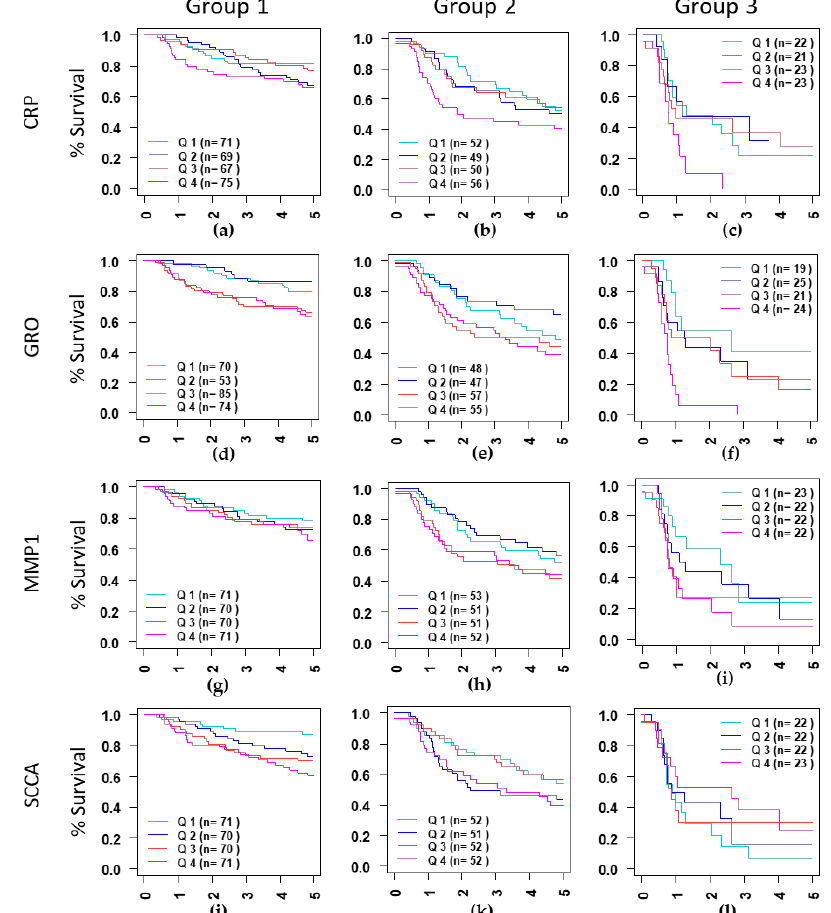
Figure 1. Kaplan-Meir curves curves for CPR ( a – c ), showing differences in survival in three groups identified based on stage (II and III) and treatment type (EBRT and EBRT+BT). Group 1: Stage II treated with EBRT+BT ( a , d , g , j ), Group 2: Stage III treated with EBRT+BT ( b , e , h , k ) and Group 3: Stage III treated with EBRT alone ( c , f , i , l ). serum level for each protein was divided into quartiles containing 25% of patients, Q1: Quartile 1 (0–25%), Q2: Quartile 2 (25–50%), Q3: Quartile 3 (50–75%) and Q4: Quartile 4 (75–100%). Quartile 1 was compared to Q2–Q3.